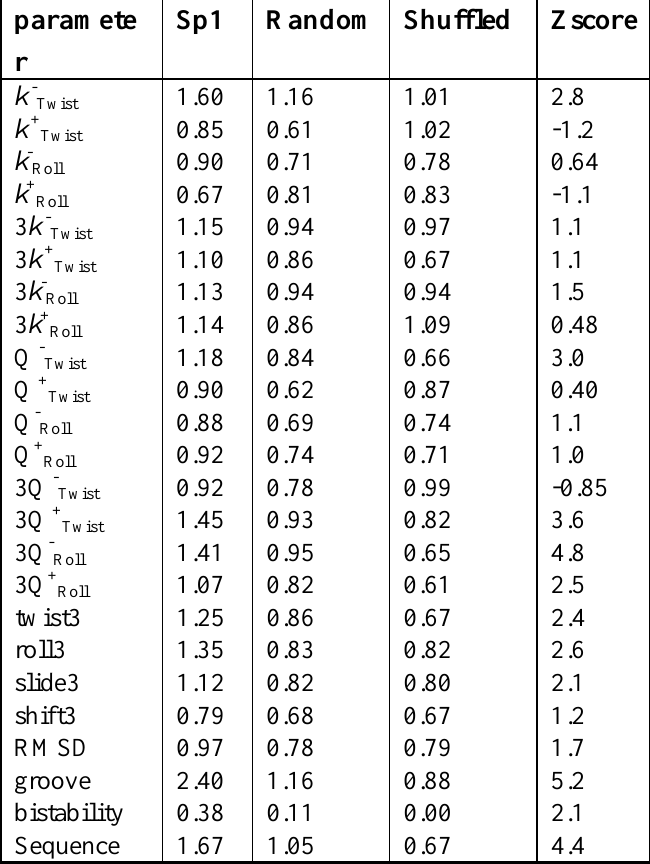
Table 2. Sp1 tfbs retrieval in chromosome 21. Random